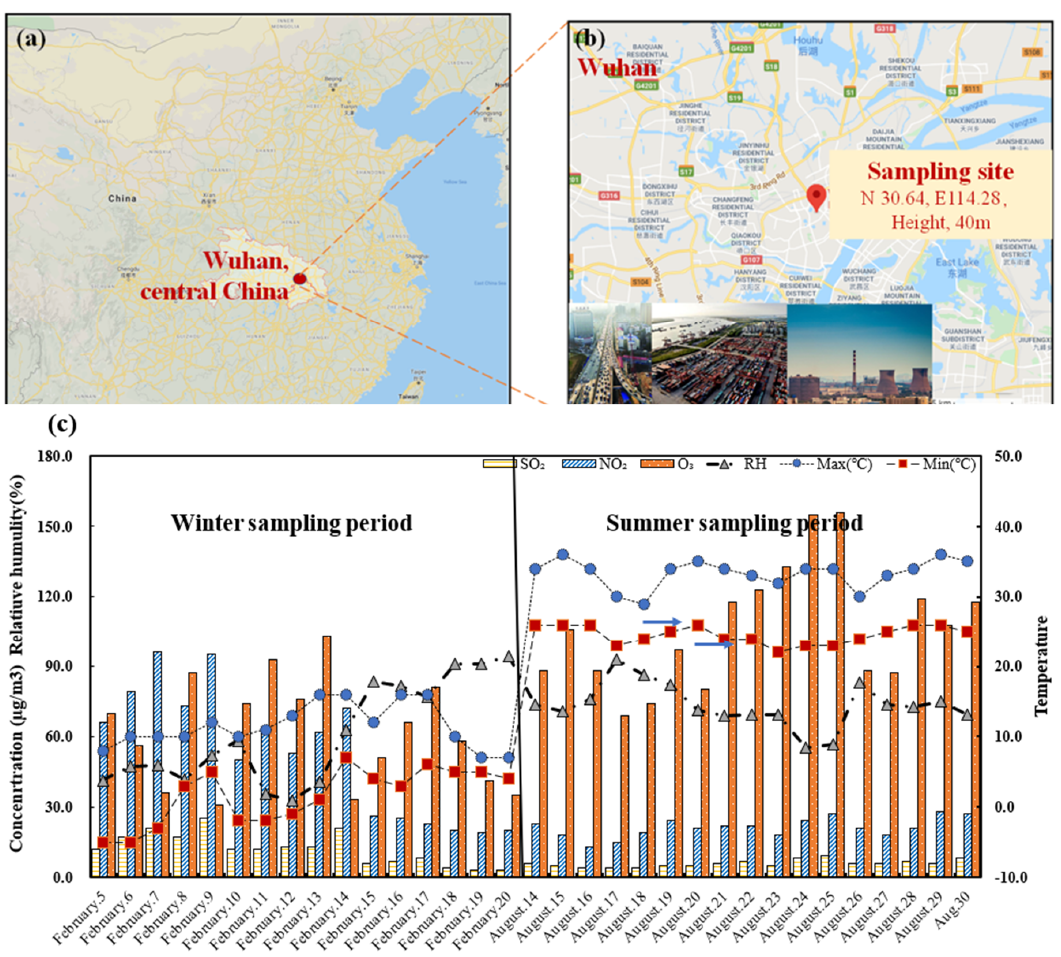
Figure 1. Location of sampling site. ( a ) Location of Wuhan, the central region of China; ( b ) sampling site in Wuhan City (N30.64, E 114.28); ( c ) meteorological factors and atmospheric pollutants in each sampling period (5–20 February; 14–30 August).